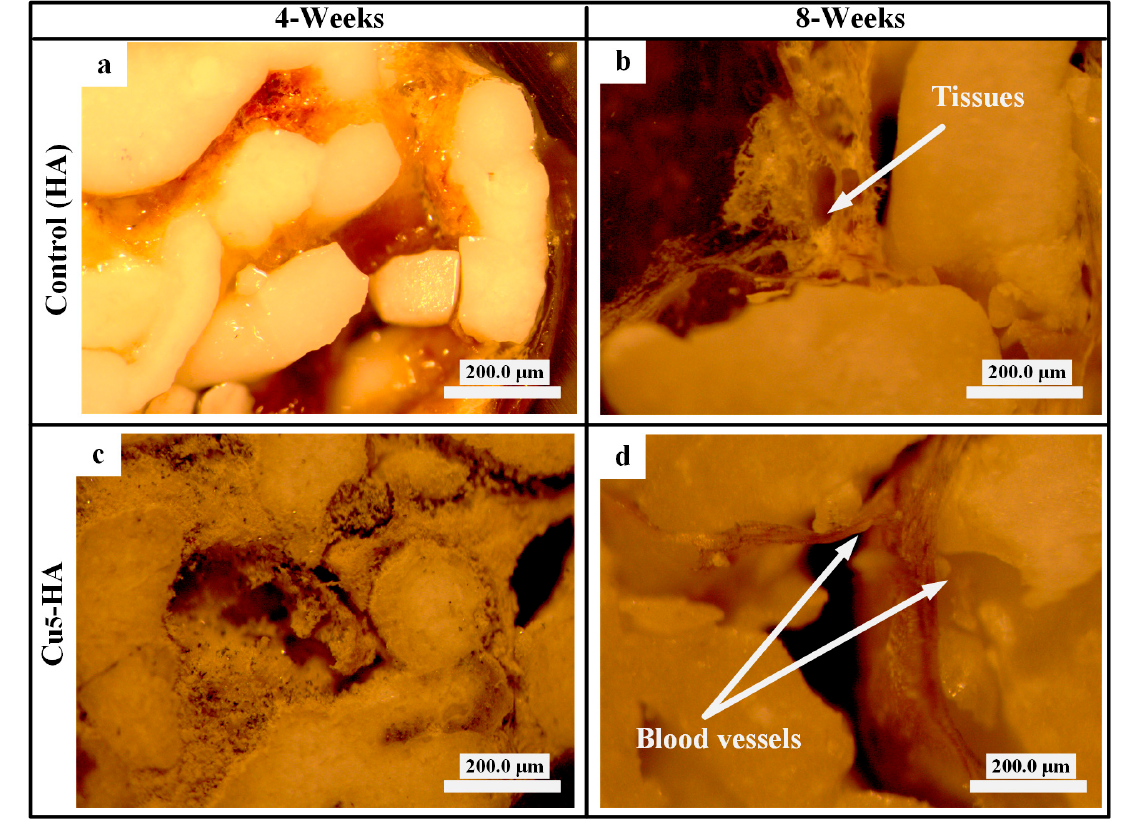
Figure 12. Optical microscopic characterizations of the HA and Cu 5 -HA scaffolds after eight weeks of implantation. ( a , b ) Tissues attached to HA scaffold and ( c , d ) blood vessel on Cu 5 -HA scaffolds.